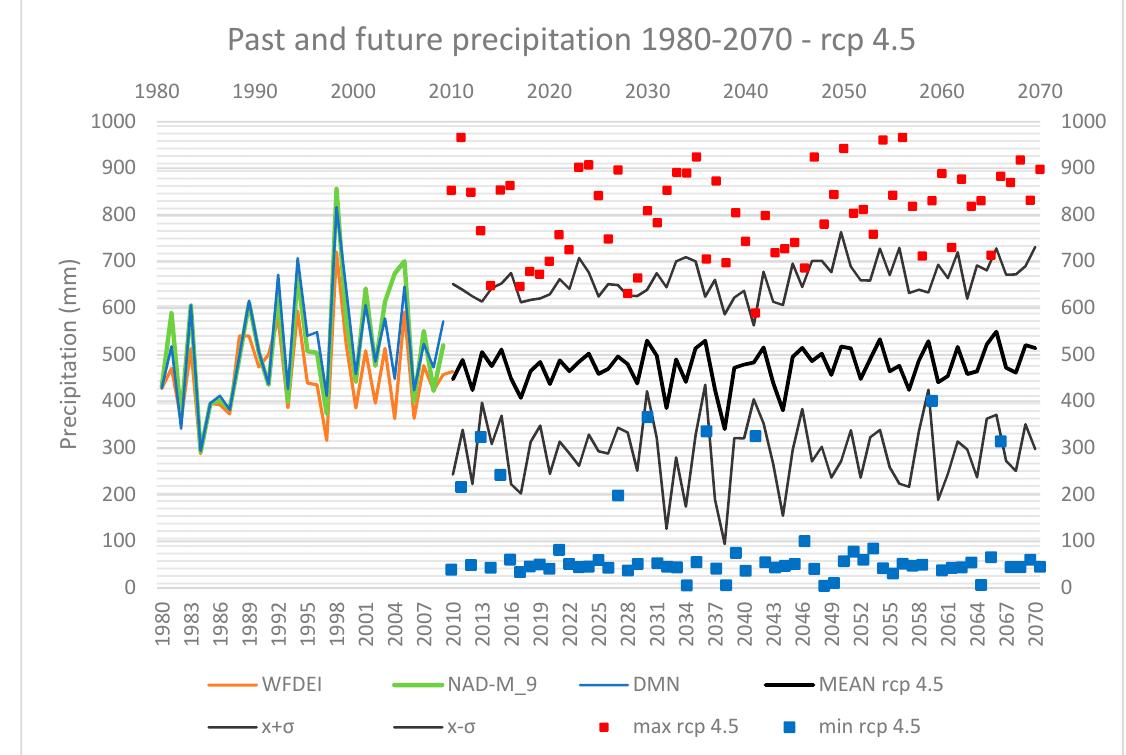
Figure 8 . Past and future precipitation 1980–2070—rcp 4.5. Figure 8. Past and future precipitation 1980–2070—rcp